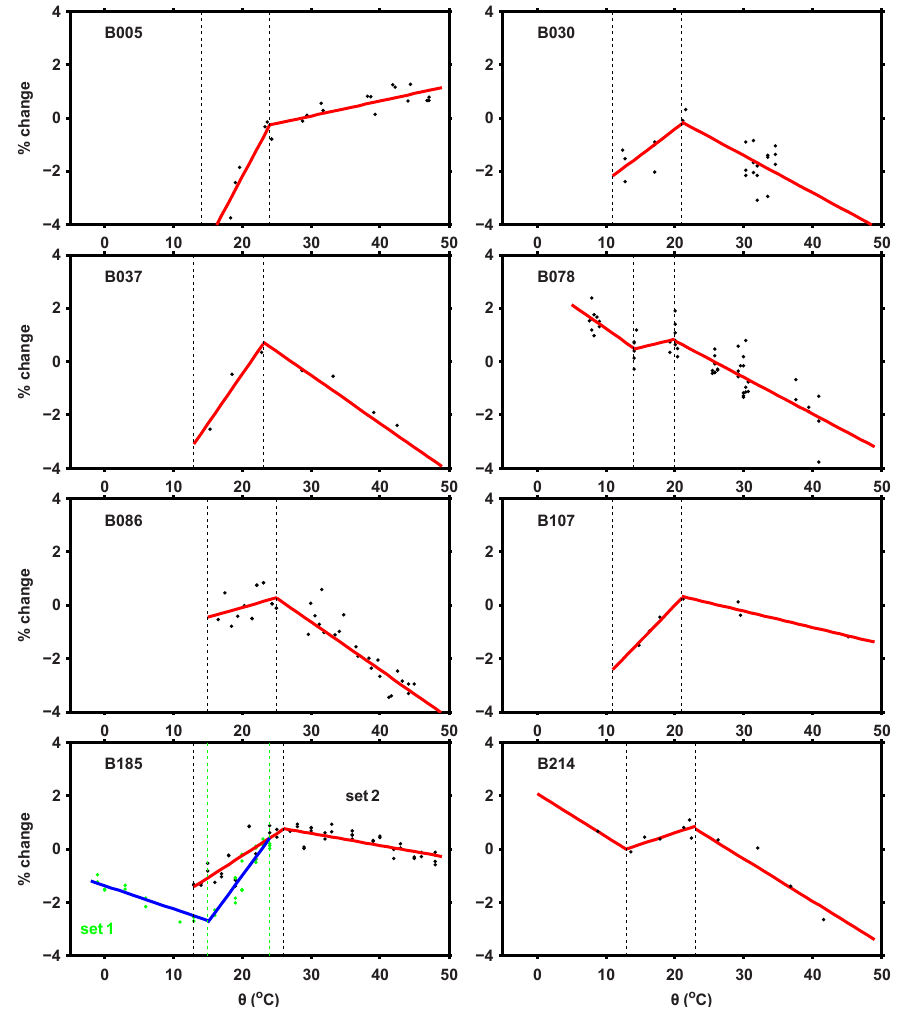
Figure 3. Change (in %) in irradiance at 315nm with respect to the instrument’s internal temperature for eight Brewer spectrophotometers. The estimated limits that separate the three TRs for each instrument are represented by the two dotted lines, while the linear fits that describe the change in each instrument’s response are represented by the red lines. For B185 the two sets of measurements are represented by different colors (green and black) as well as the corresponding linear fits (blue and